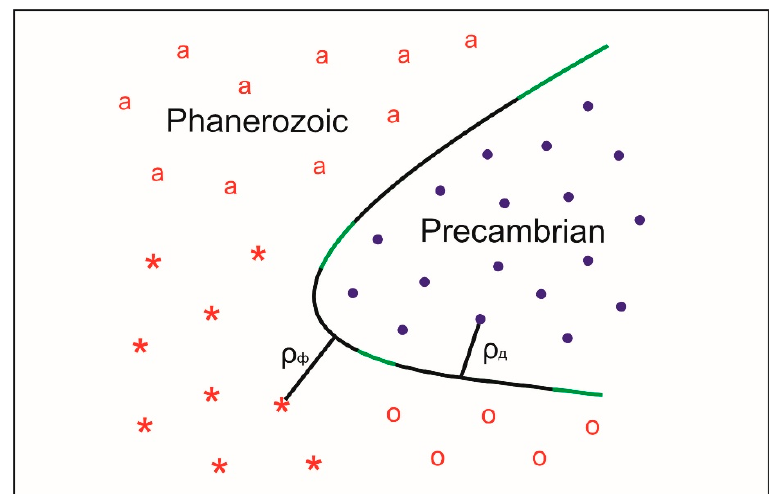
Figure 5. Schematic reconstruction of settings based on a quadric surface: a , * , o for the Phanerozoic rock assemblages formed in different geodynamic settings, • for the Precambrian rock assemblages; ρ Ф for the proximity of a certain Phanerozoic rock assemblage represented by a set of figurative points in a space of chemical rock composition which has parameters similar to the simulated quadratic surface in relation to chosen metrics, and ρ Д for the proximity of a certain Precambrian rock assemblage to the surface respectively.